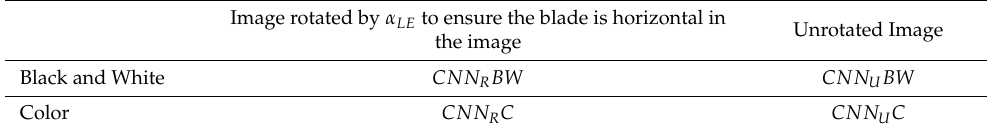
Table 4. Configurations for Mask R-CNN sensitivity study.